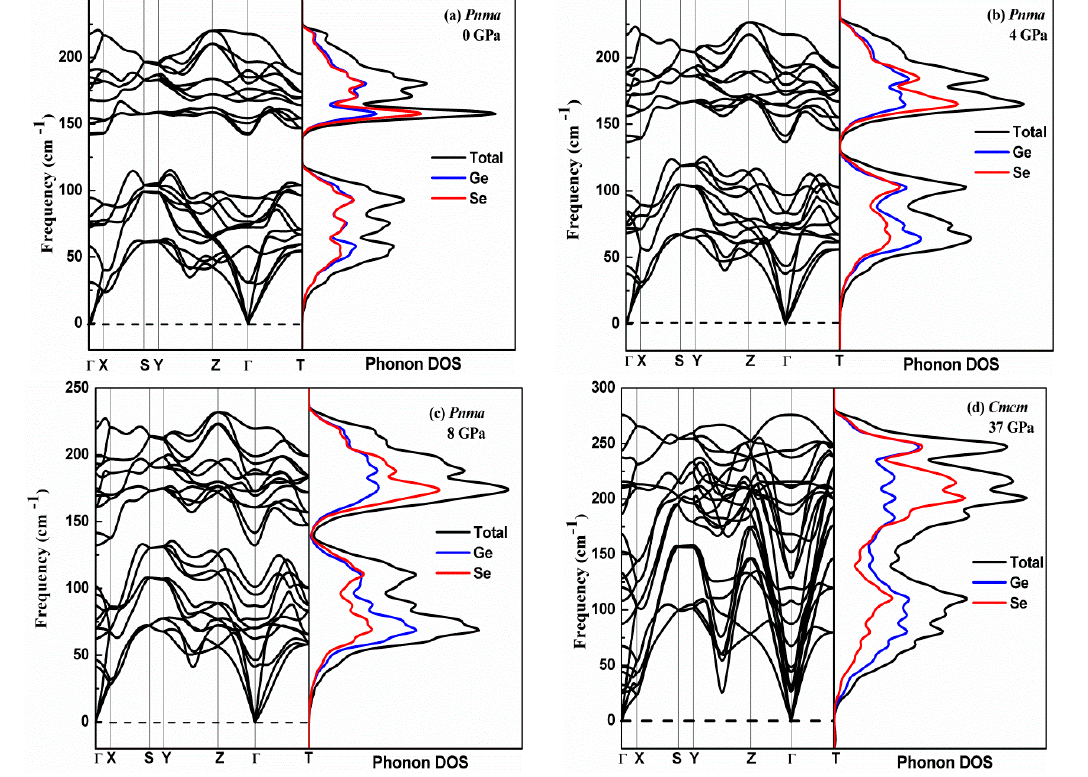
Figure 7. Phonon dispersion and phonon density of states (DOS) of GeSe along the high-symmetry directions at di ff erent pressures: ( a ), ( b ) and ( c ) at 0 GPa, 4 GPa and 8 GPa in Pnma phase, respectively; ( d ) at 37 GPa in Cmcm phase.